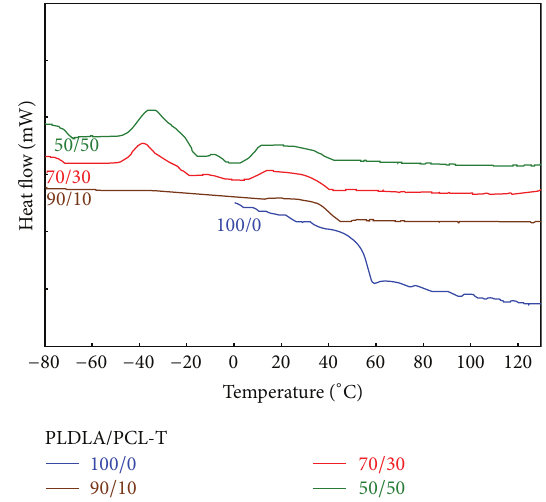
Figure 3: DSC curves for the second heating of membranes containing PLDLA/PCL-T blends of 100/0, 90/10, 70/30, and